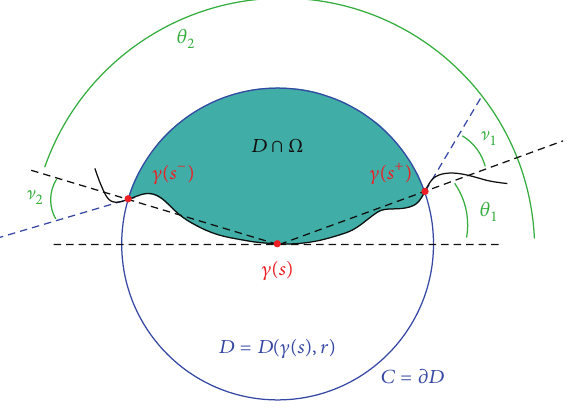
Figure 6: Notation and